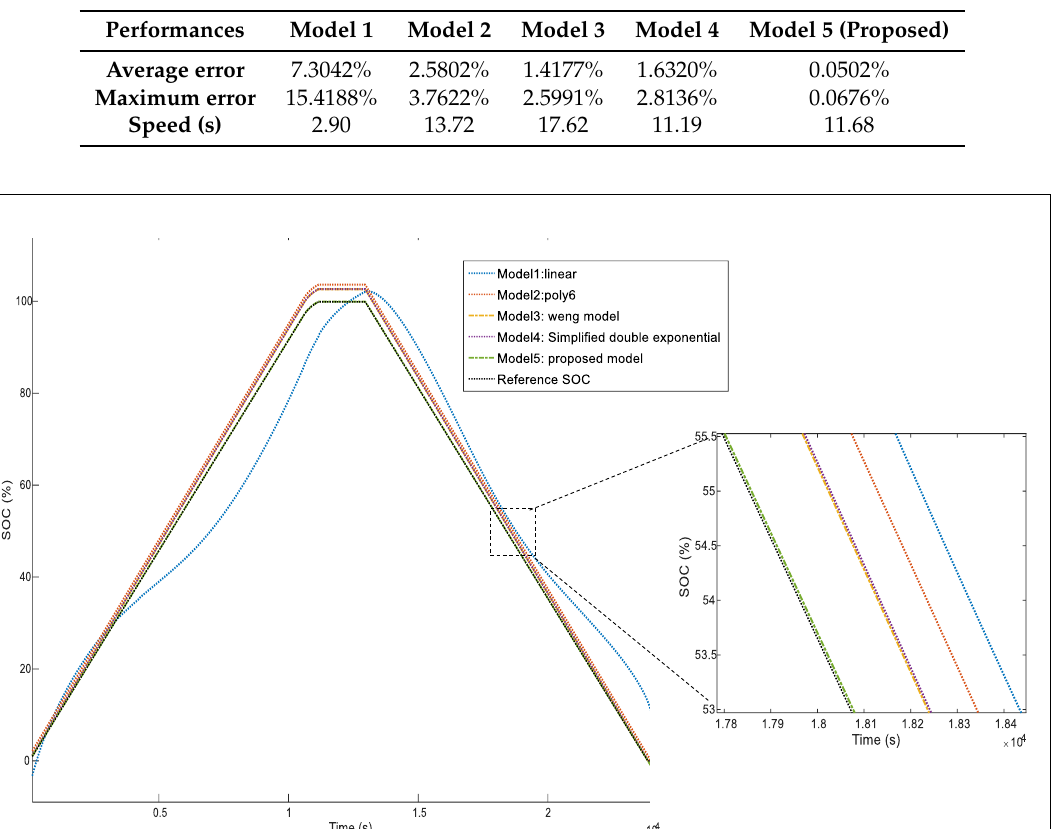
Table 9. EKF estimation error (constant current load) at 25 ◦ C.